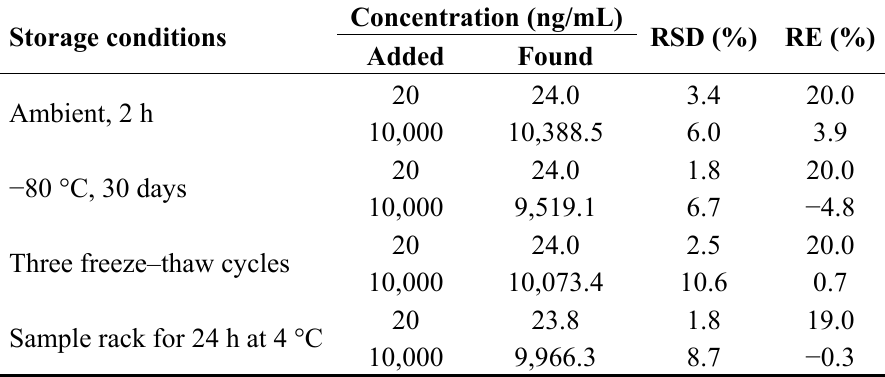
Table 3. Stability of azacitidine in rat plasma exposed to various storage conditions (n =